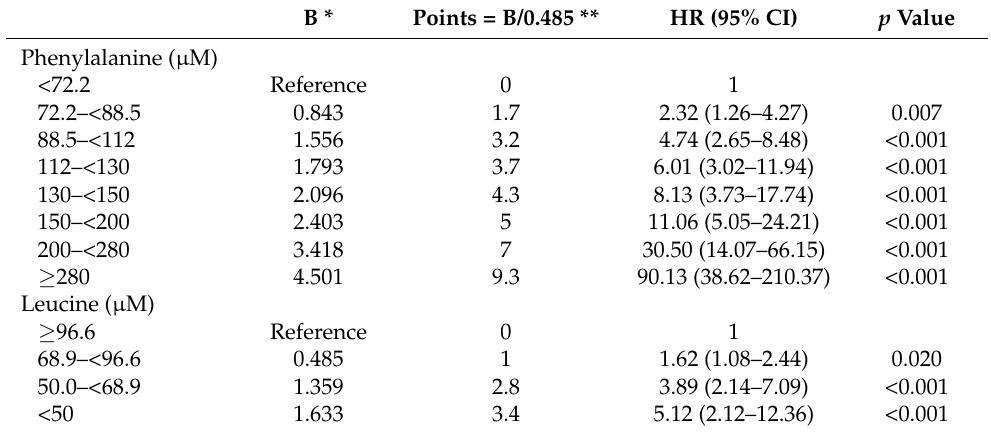
Table 2. Multivariable Cox logistic regression for the PLA score calculation to predict 30-day mortality.